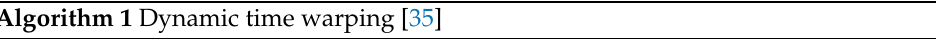
Figure 3. Dynamic Time Warping Alignment of two signature signals. The blue line and the orange line represent two signatures respectively while the yellow line shows